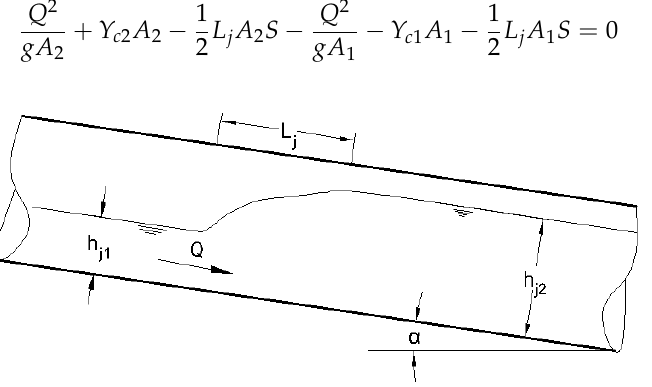
Figure 4. Direct hydraulic jump in a circular sewer pipe flowing partially